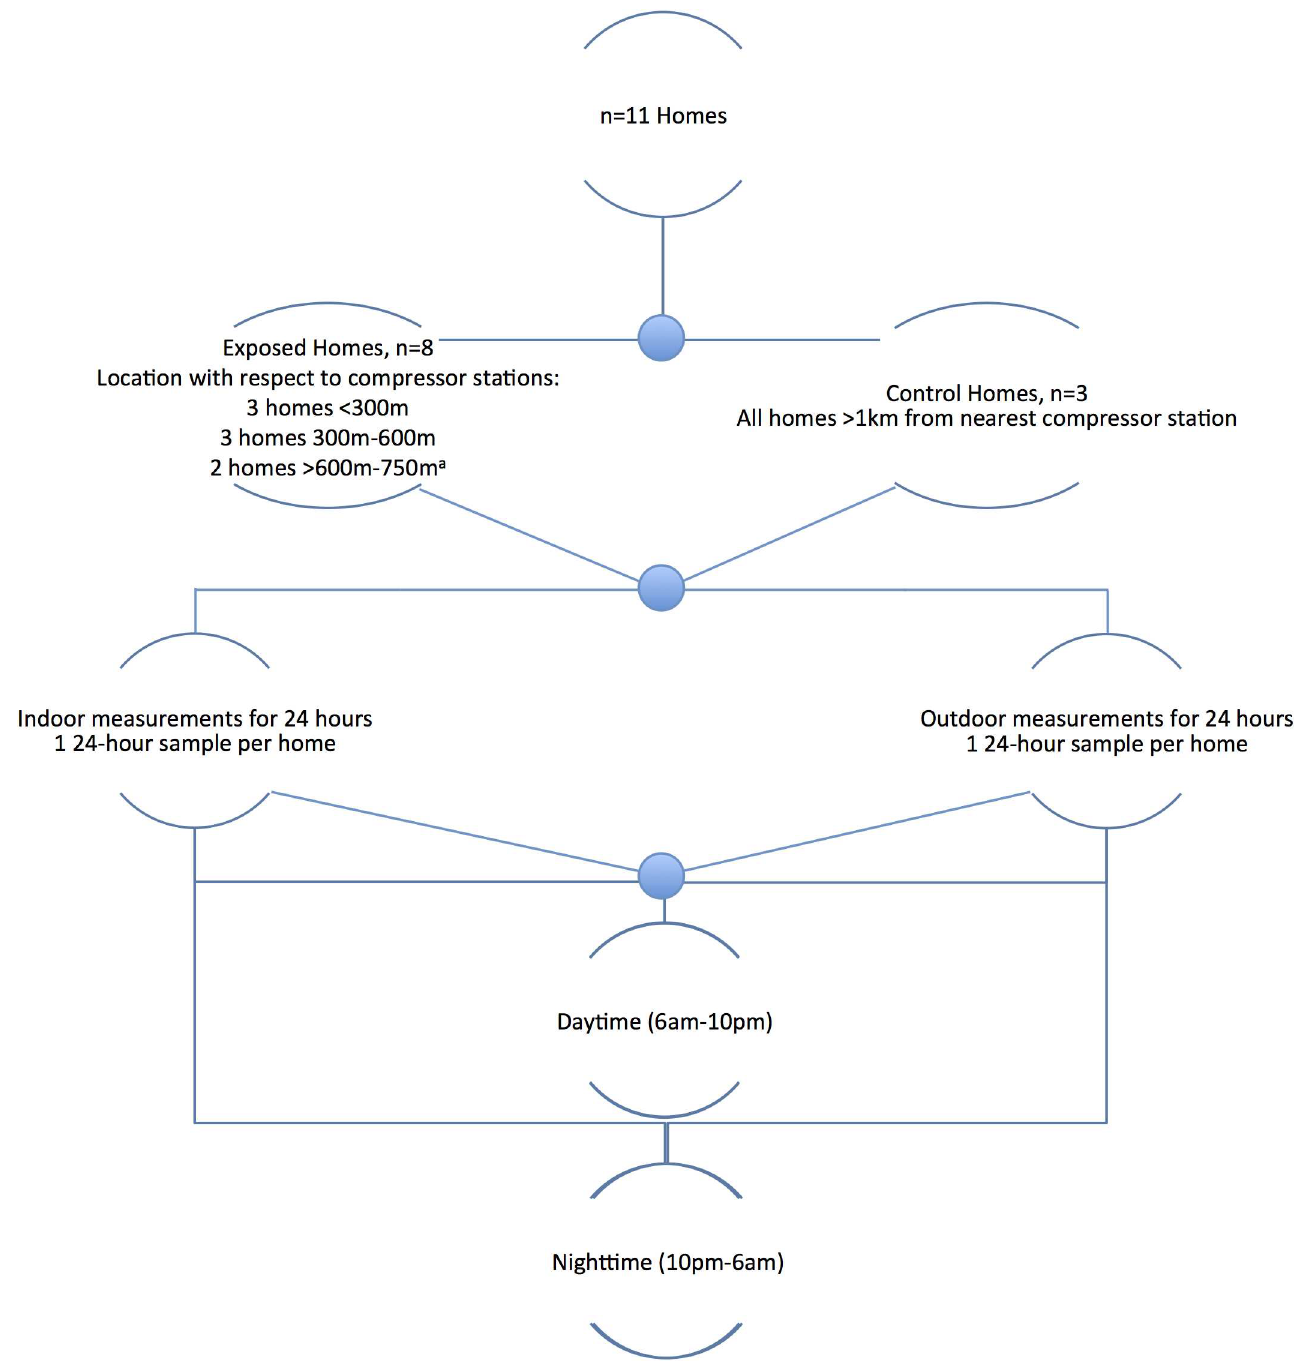
Fig 1. Study design of aggregated noise measurements by exposed homes vs. controls, location (indoors vs. outdoors), and time of day (daytime vs. nighttime).